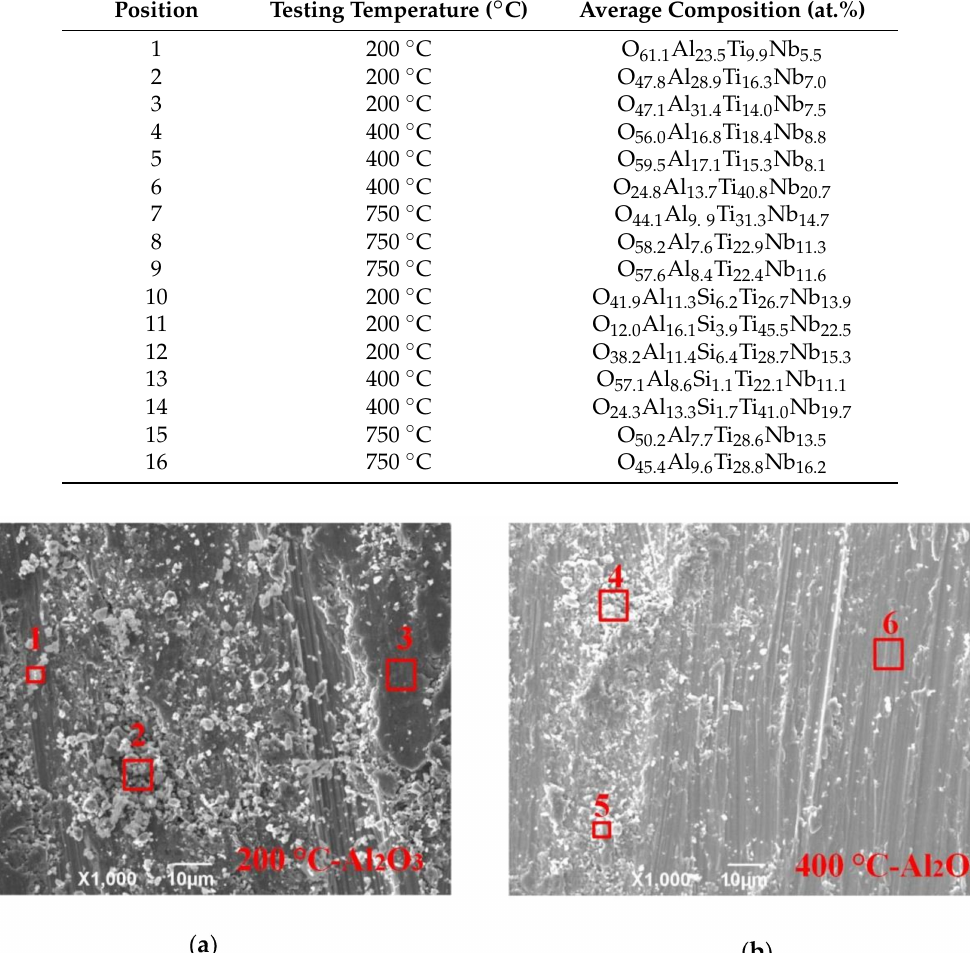
Table 1. Average element composition of the worn areas of the Ti-22Al-25Nb alloy (at. %) at different counterface materials and temperatures obtained by energy dispersive spectroscopy (EDS).